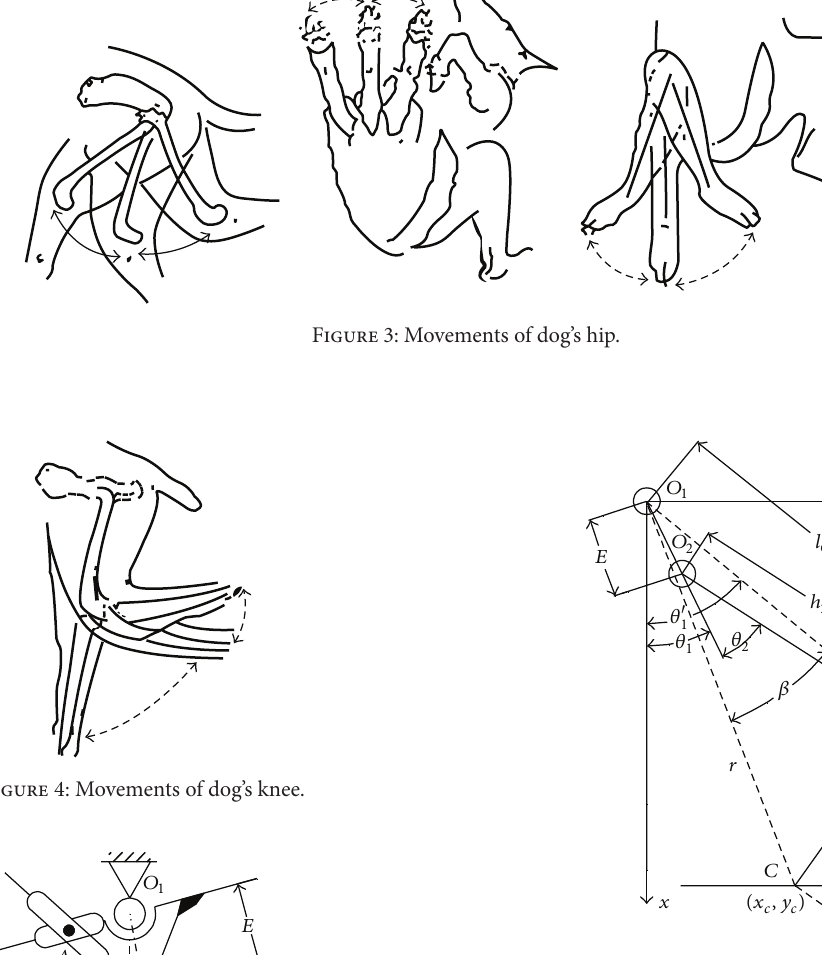
Figure 6: Schematic diagram of robot leg in the Cartesian coordi- nate